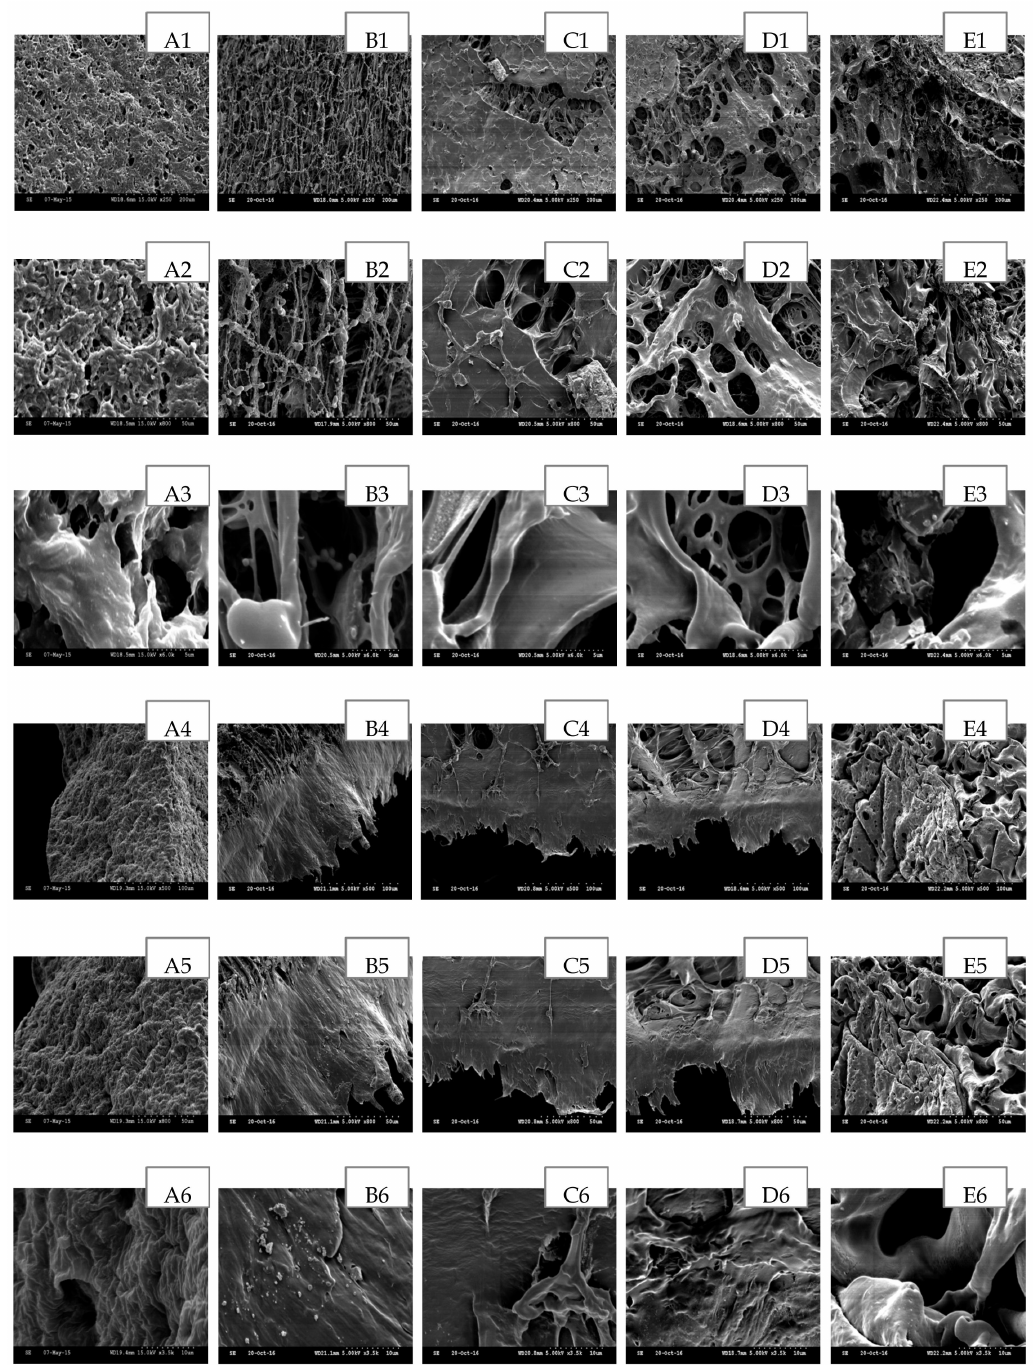
Figure 6. SEM images of in situ loaded DIC hydrogel network in comparison with unmedicated hydrogel cross-linked with 5% w / w PETRA. ( A ) Unmedicated PEO, ( B ) PEO-DIC 3.17% w / w , ( C ) PEO-DIC 8.37% w / w , ( D ) PEO-DIC 13.12% w / w , ( E ) PEO-DIC 20.26% w / w . Scale bars are 200 µ m, 50 µ m and 5 µ m for micrographs featuring the outer surface of hydrogel network (1–3), 100 µ m, 50 µ m, and 10 µ m for micrographs featuring the cross section of hydrogel network